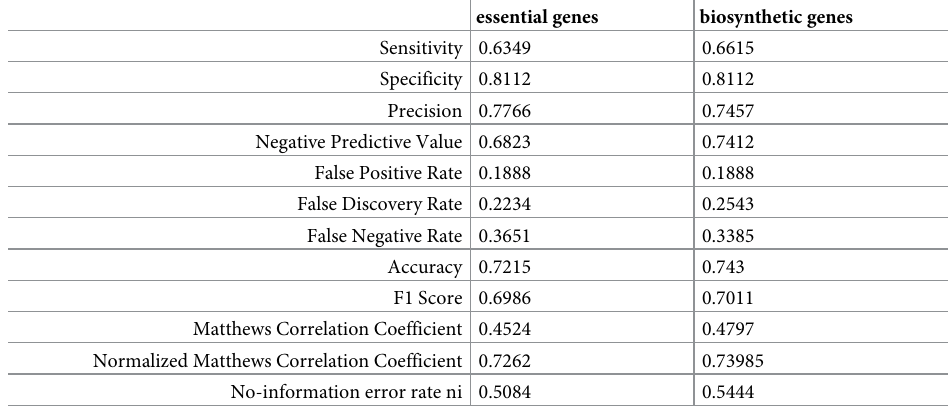
Table 3. Statistical evaluation of the performance of FunOrder in detecting relevant genes in